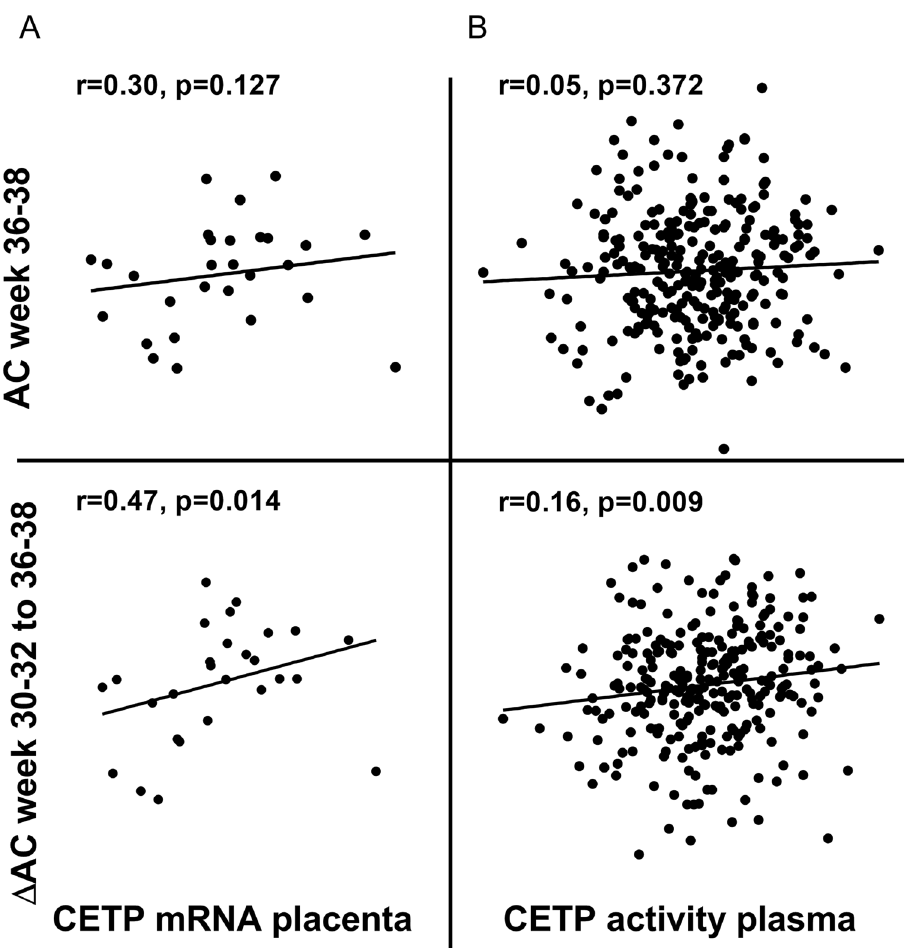
Figure 3. Correlation plot between ( A ) CETP mRNA in the placenta and abdominal circumference (AC) and the difference in AC between week 30–32 to 36–38, ( B ) CETP activity in plasma and AC and the difference between AC from week 30–32 to 36–38.